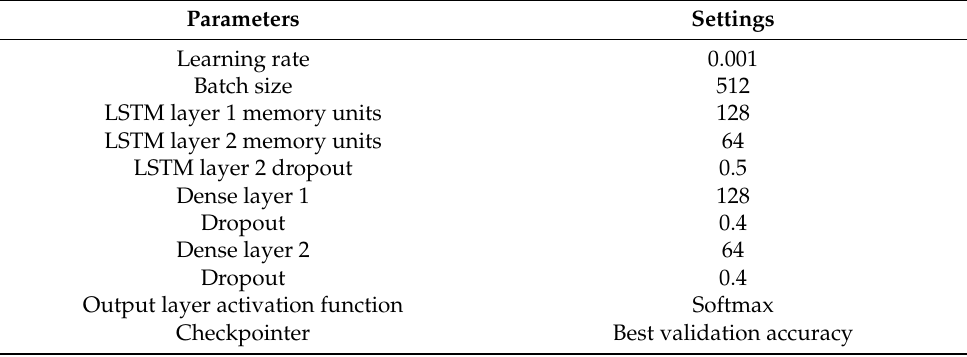
Table 5. Parameter description of LSTM model with embedding layer.